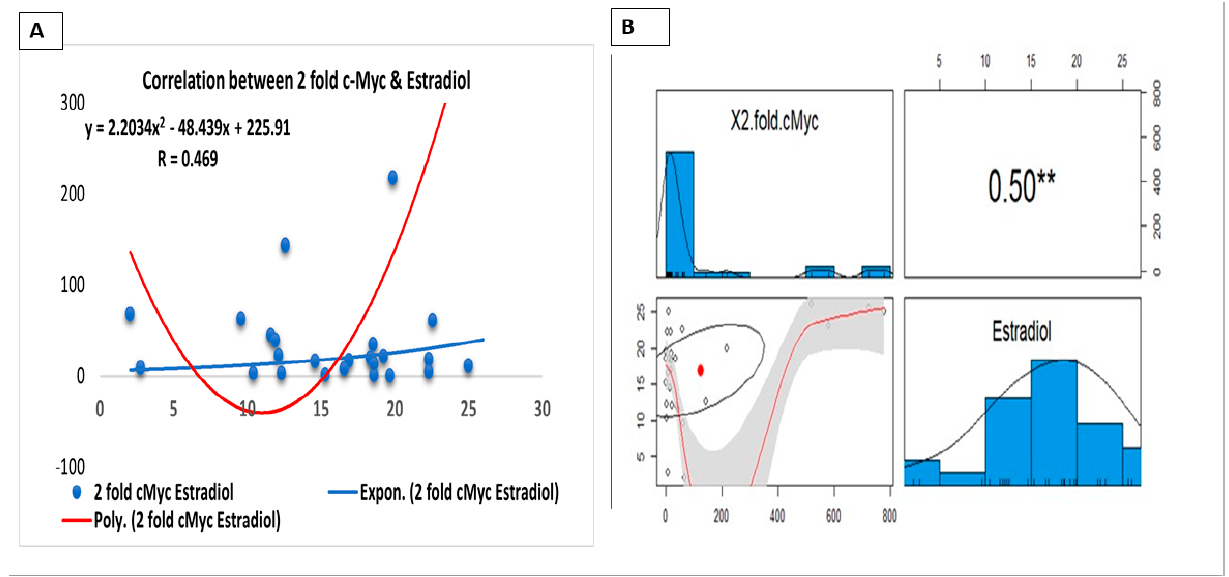
Figure 8. ( A ) Correlation coefficient (R = 0.469) showed a positive relation between estradiol and c-myc. Blue line indicates linear regression and red curved line represents polynomial regression. ( B ) Showing multiple linear correlation studied in R using Psych package. Significant correlation exists between c-myc and estradiol at df = 1, R = 0.50. ** Correlation is significant at 0.01 level (two tailed). Red line shows poly regression analysis.